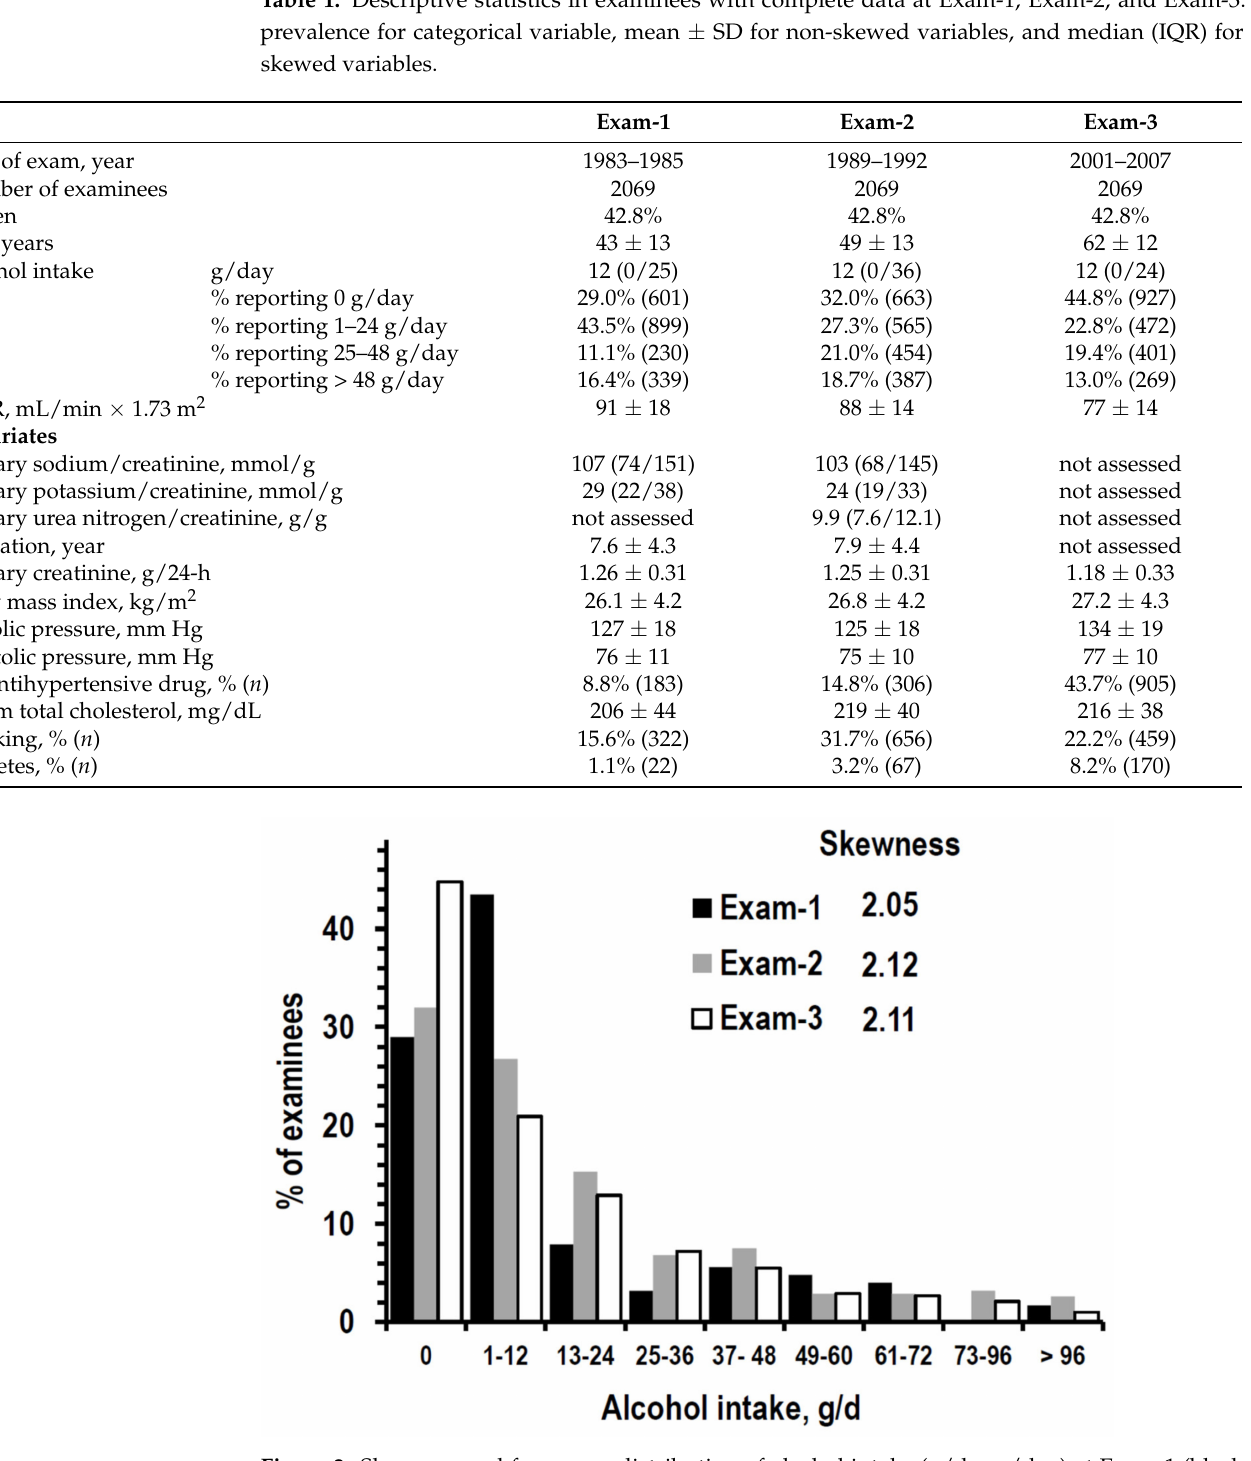
Figure 2. Skewness and frequency distribution of alcohol intake (g/d = g/day) at Exam-1 (black bars), Exam-2 (grey bars), and Exam-3 (white bars) in the 2069 examinees with complete data at all